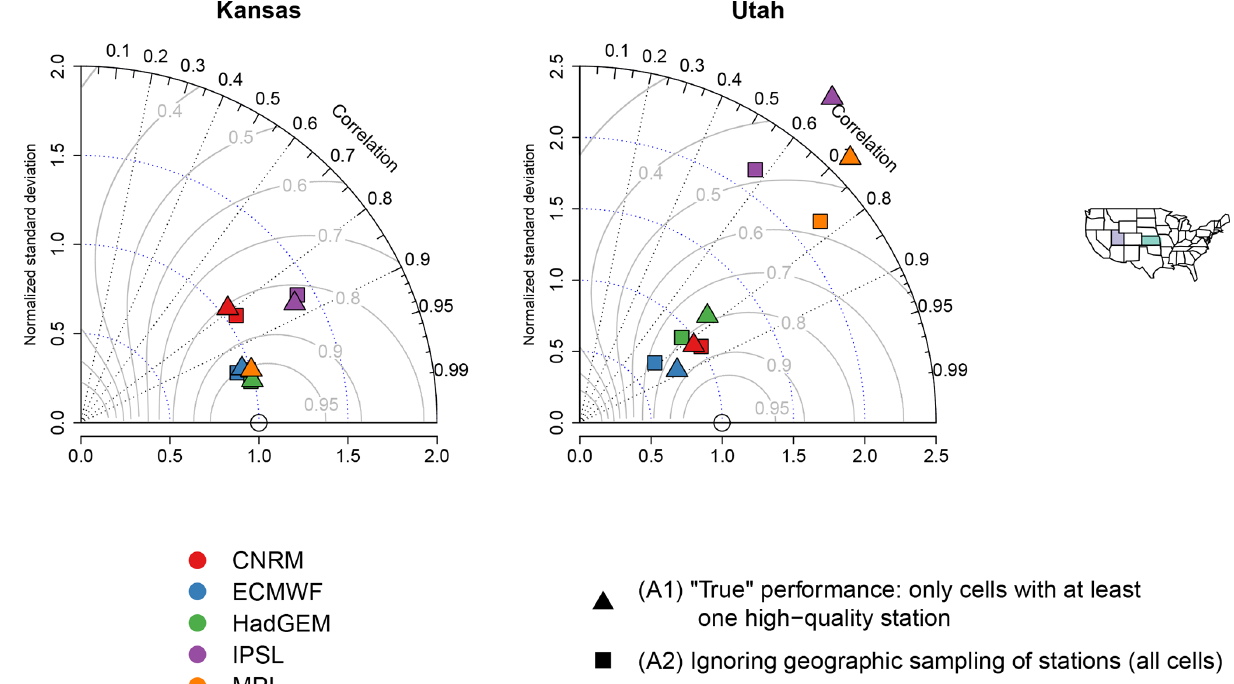
Figure 3. Taylor diagrams comparing 20-year return values for Kansas and Utah for the climate models versus regridded L15. The gray curvilinear lines represent the skill score for each model relative to the regridded L15.